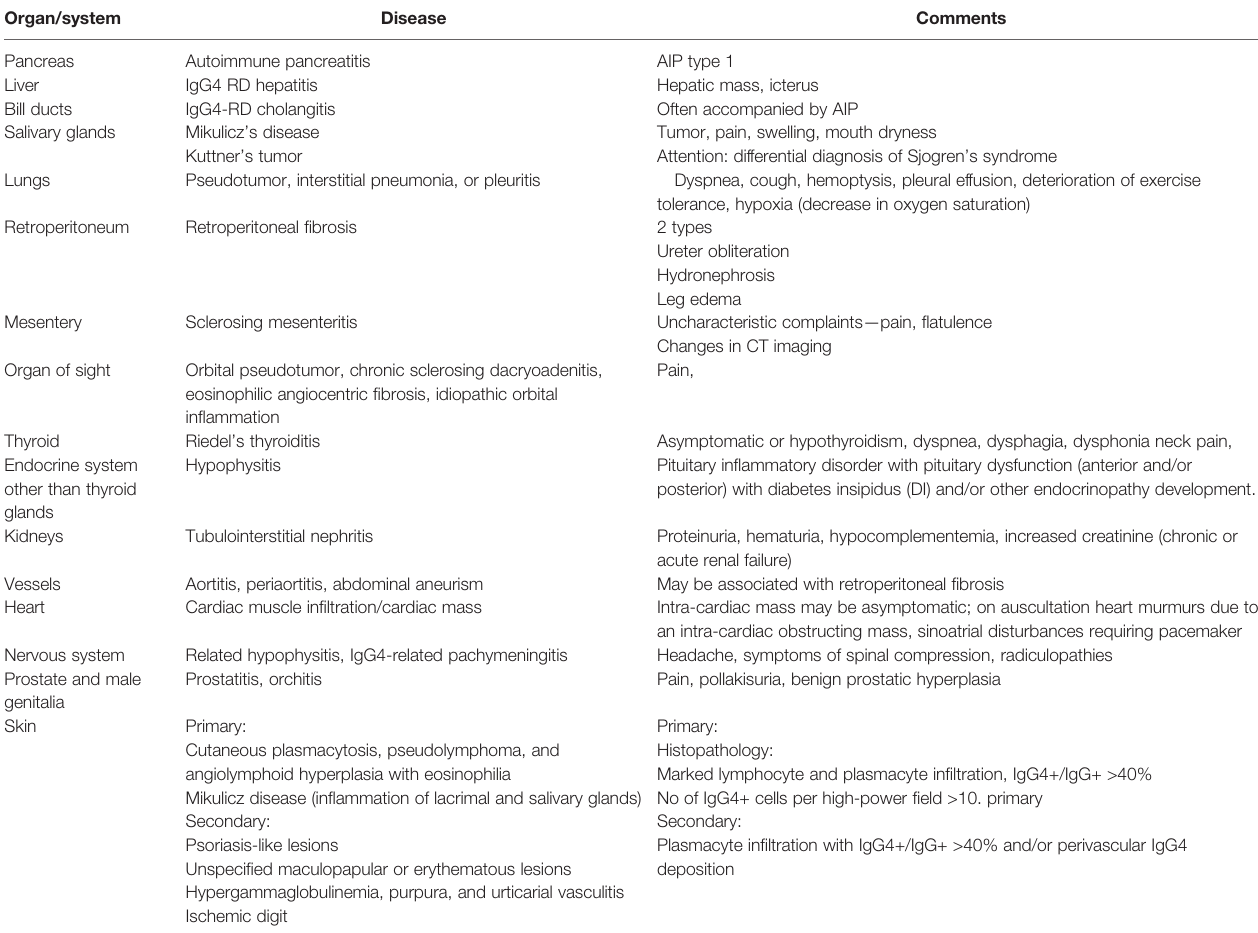
TABLE 4 | The list of IgG4-RD (52 –